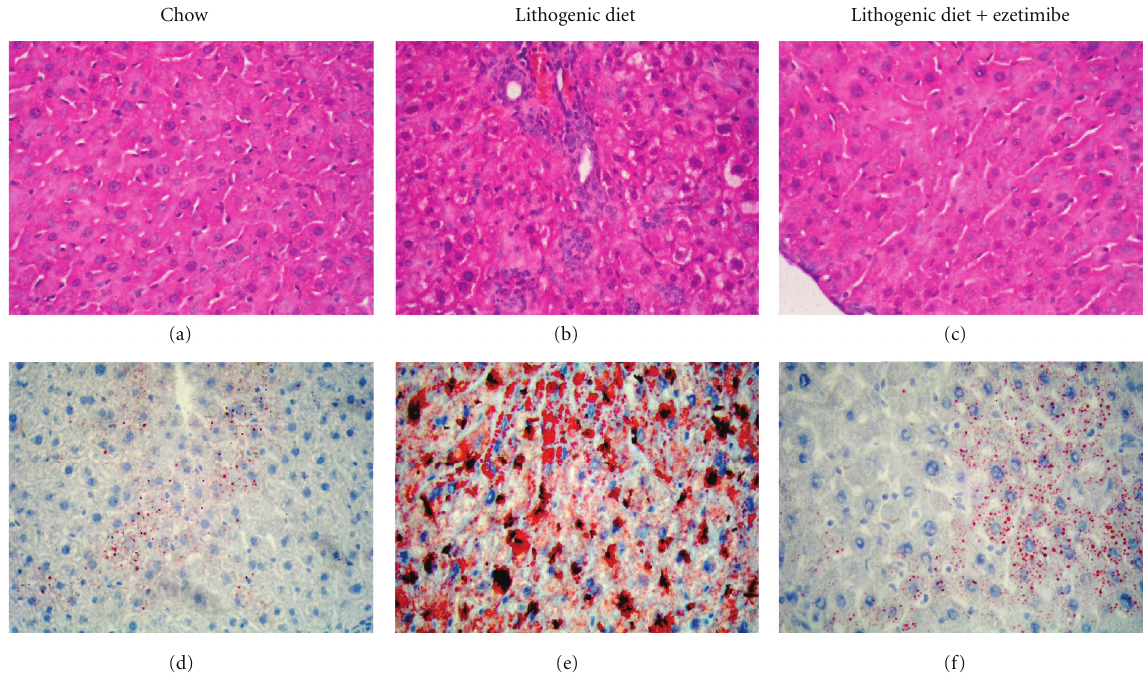
Figure 7: Histological characterization of the hepatic response to ezetimibe in mice fed a chow versus a lithogenic diet for 4 weeks. The liver samples from mice fed with di ff erent diets and treated with or without ezetimibe were isolated and subjected to histological analysis. Panels (a)–(c) show representative liver histology with hematoxylin-eosin staining and panels (d)–(f) show Oil Red O staining. (a) and (d) Mice fed with the chow diet. (b) and (e) Mice fed with the lithogenic diet without ezetimibe. (c) and (f) Mice fed eith the lithogenic diet with ezetimibe. The lithogenic diet induced a significant accumulation of triglyceride and cholesteryl ester in the liver as well as hepatocyte damage and inflammation. Interestingly, ezetimibe treatment markedly reduced the accumulation of lipids and prevented hepatic inflammation. Reproduced with modifications and with permission from